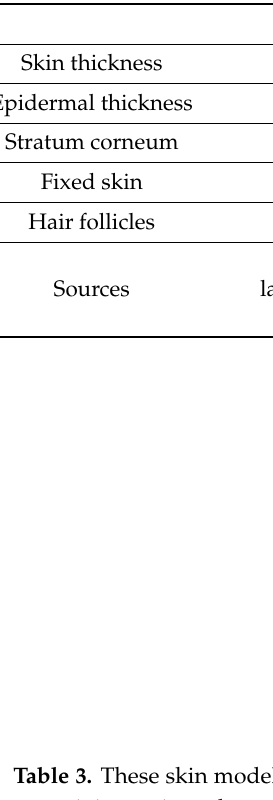
Table 3. These skin models are commercially available [35–37]. They are mostly used in the areas such as skin